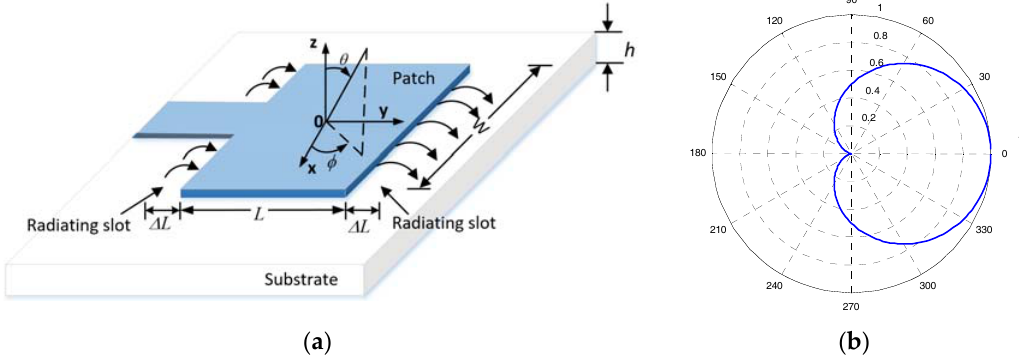
Figure 1. Schematic diagram ( a ) and radiation pattern ( b ) of the rectangular microstrip antenna.